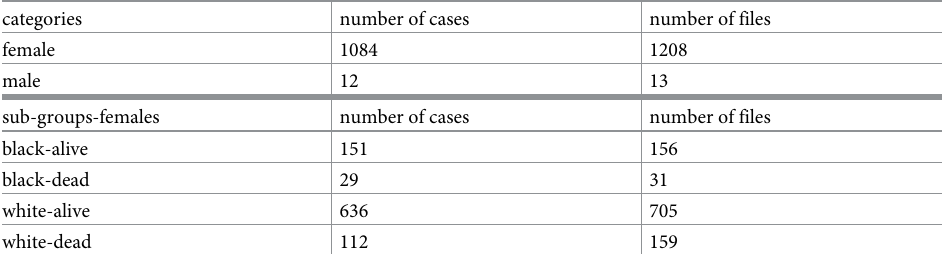
Table 2. Data set for BRCA.